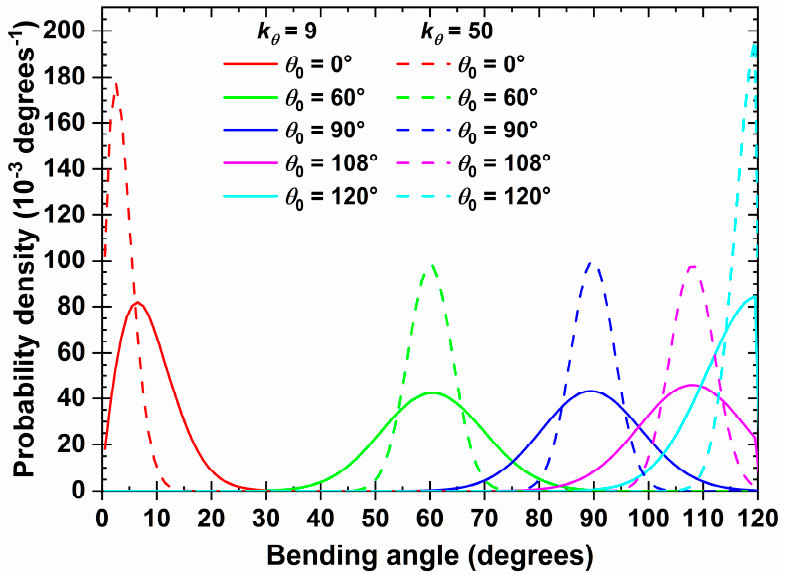
Figure 2. Distribution of bending angle, θ , of a 100-chain system of N av = 12 at ϕ = 0.30 in the bulk for k θ = 9 (solid lines) and 50 (dashed lines) and different equilibrium bending angles, θ 0